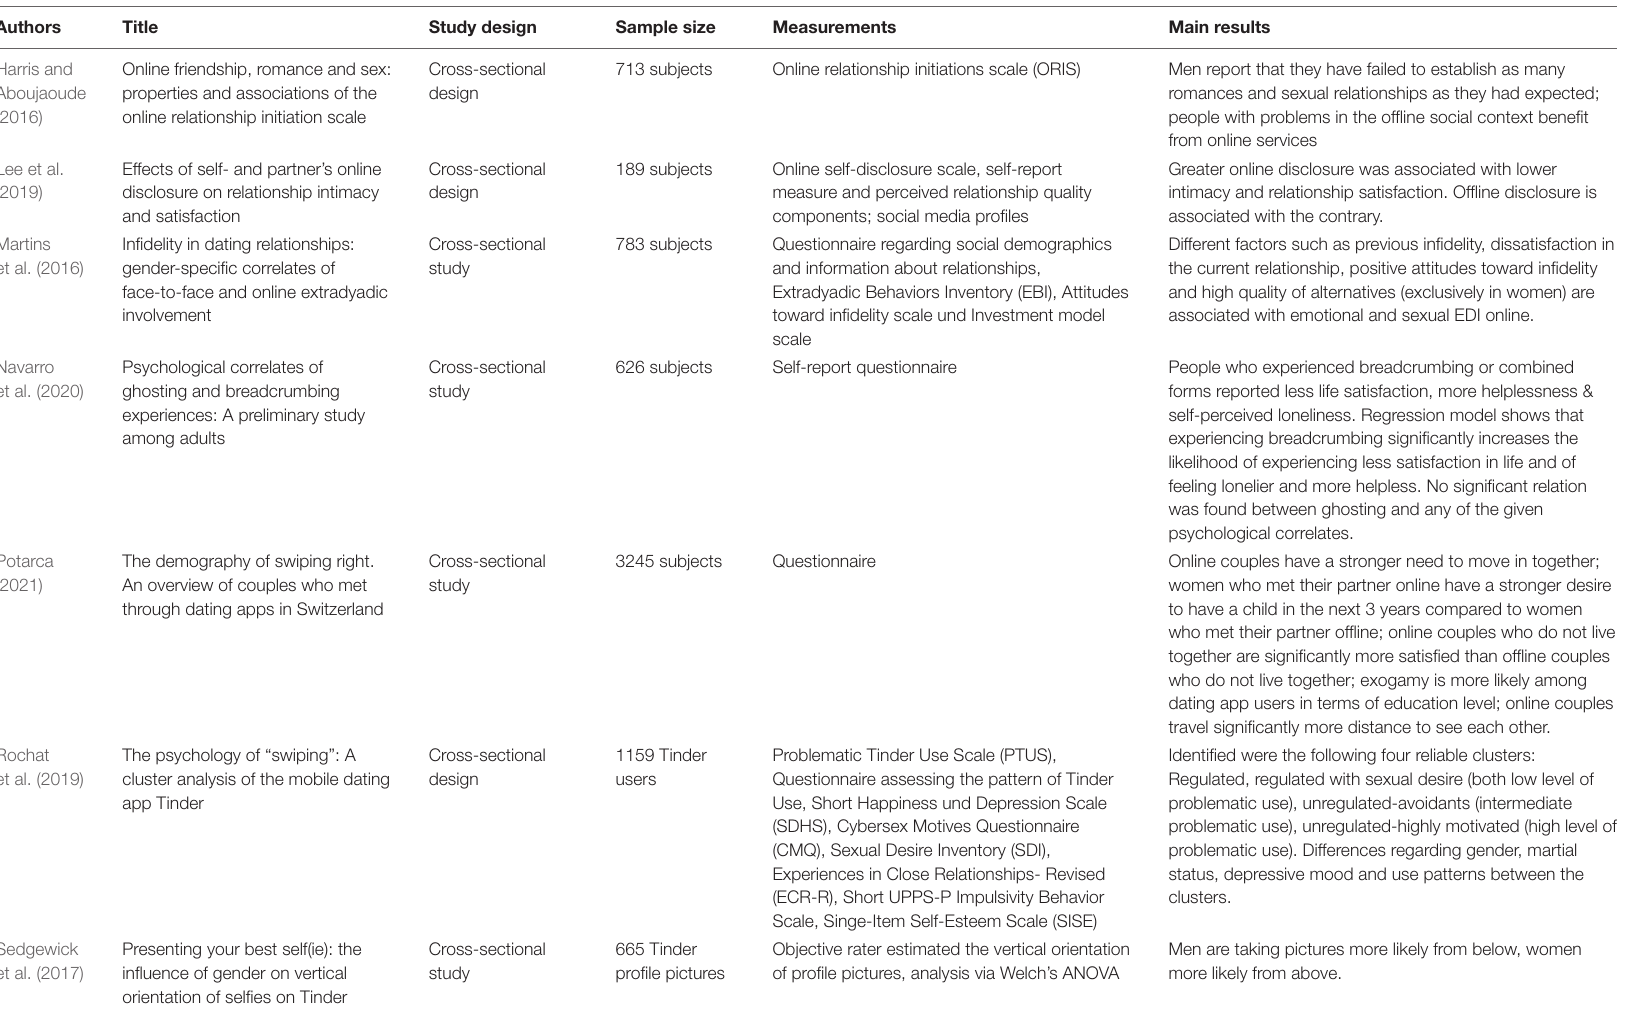
TABLE 1 | Studies included in the selective